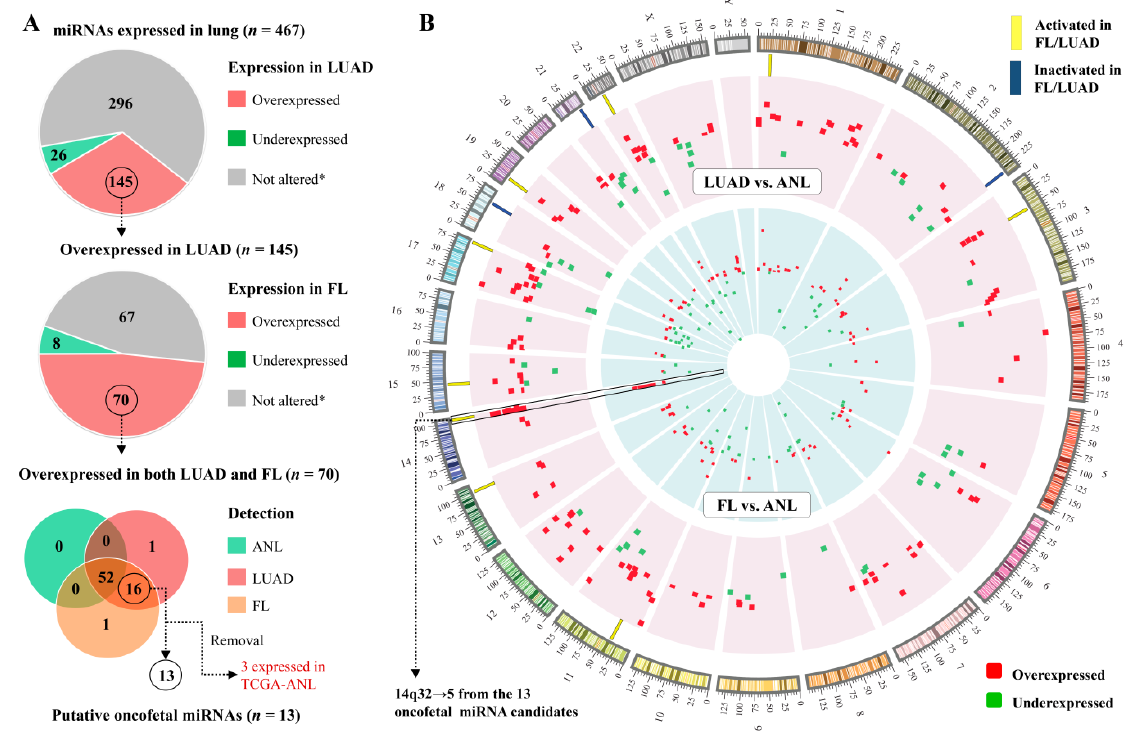
Figure 2. Many miRNAs display an oncofetal expression pattern. ( A ) Pie charts and Venn diagram illustrating the criteria for classifying miRNAs as oncofetal. * Statistically significant differences in expression were not observed in both datasets (BCWH and TCGA), or the sequence did not meet the expression threshold (RPM ≥ 1 in ≥ 10% of samples) in the indicated sample group; ( B ) Circos plot [24] of the genomic locations of miRNAs that were identified as differentially expressed in the discovery (BCWH) cohort in LUAD vs. ANL (outer ring, representing 162 overexpressed and 51 underexpressed miRNAs), or in FL vs. ANL (inner ring, representing 152 overexpressed and 70 underexpressed miRNAs). Oncofetal miRNAs are indicated by yellow rectangles.